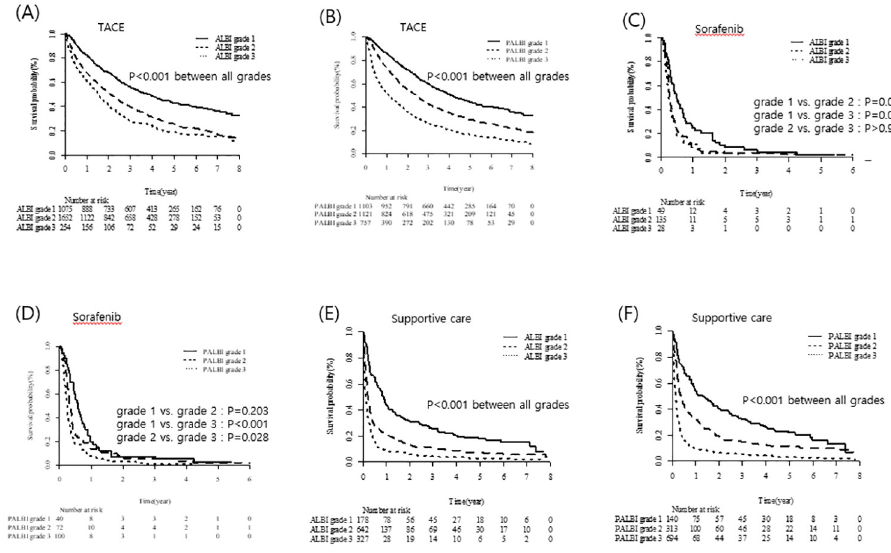
Fig 7. Utility of the ALBI and PALBI grades according to palliative treatment